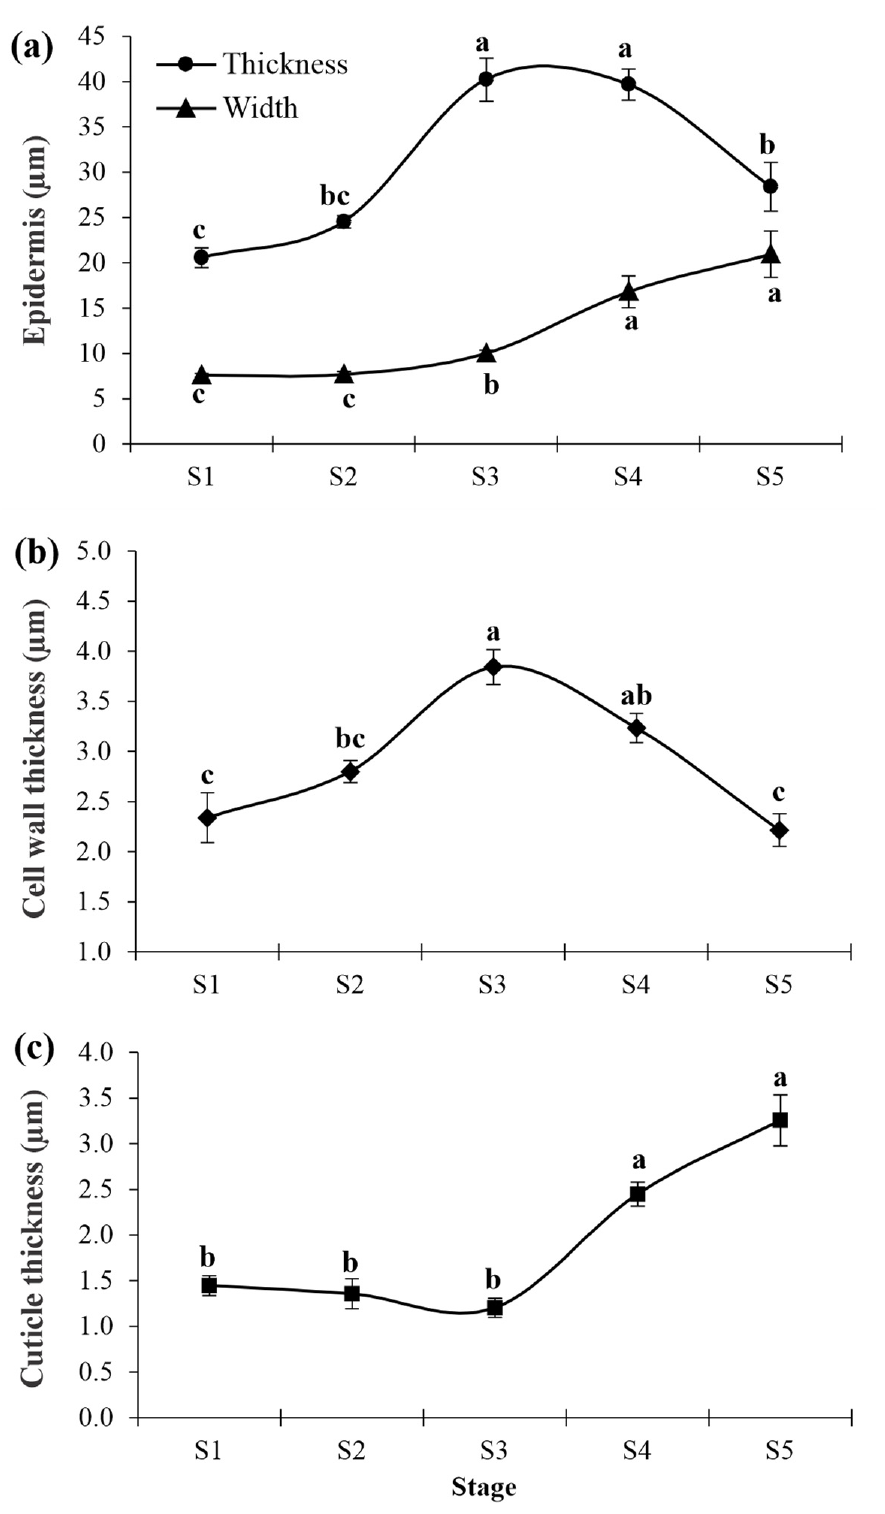
Figure 4. Epidermis thickness and epidermis cell width ( a ), epidermal cell wall thickness ( b ), and cuticle thickness ( c ) of CCP 76 cashew pseudofruits in five development stages (S1, S2, S3, S4, and S5). Means followed by different lowercase letters are significant using Tukey’s test ( p < 0.05). Vertical bars represent the standard error of the mean.